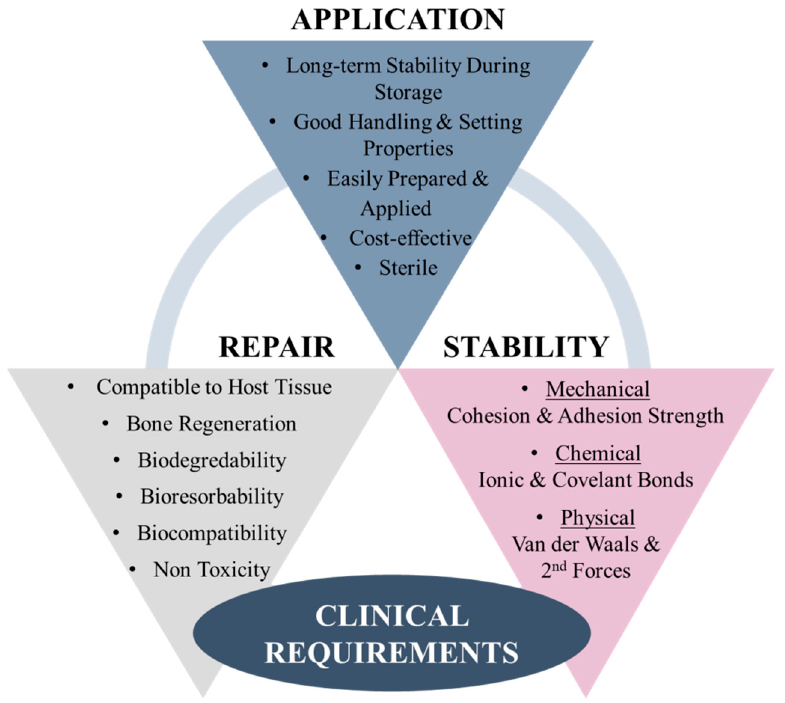
Figure 11. Clinical requirements for suitable application of adhesive for bone repair and stabilisa- tion.